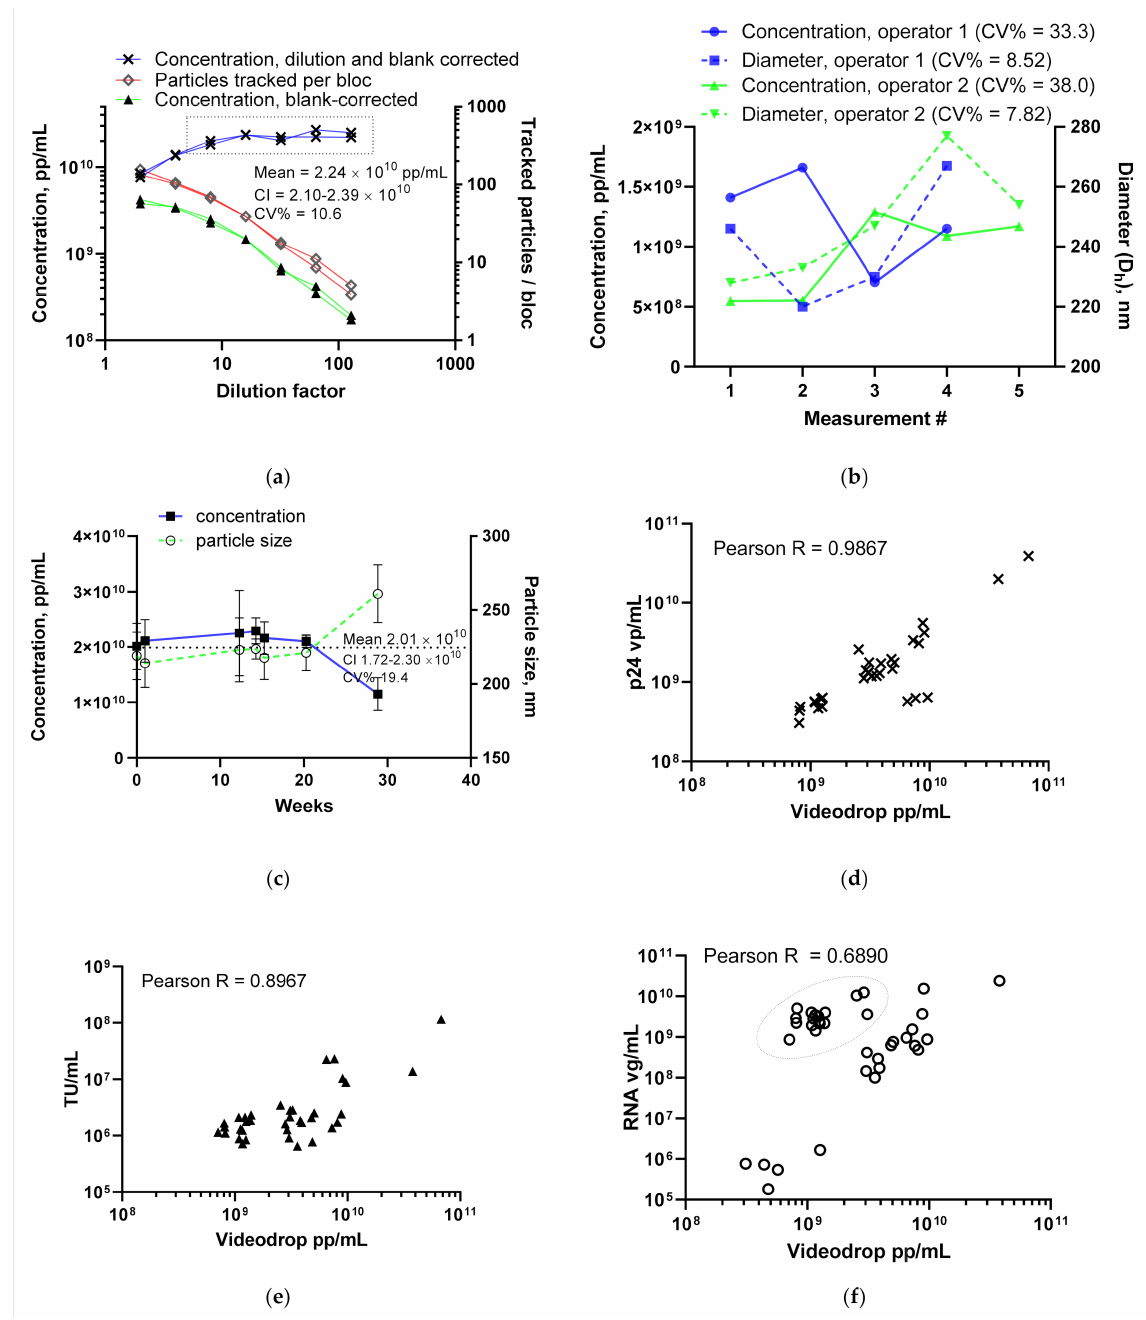
Figure 2. Videodrop LV assay results: ( a ) setting the LV assay range and minimum particle numbers. Two independent measurements of 2-fold LV dilution series (prepared fresh each time) were measured. The final blank- and dilution-corrected result as well as the blank-corrected raw reading and number of tracked particles are shown. The dotted line box shows dilutions falling within the set assay working range with their mean concentration, with the CI and CV% below. ( b ) LV repeatability results from a single 8 × dilution as analyzed by two operators during a single day. ( c ) Intermediate precision results, measured from the same sample (different aliquot tubes) over several months. The mean is displayed as a dotted line, and CI and CV% are shown under the line. ( d ) Correlation between the Videodrop measurement and vp/mL p24 ELISA result. ( e ) Correlation between the Videodrop measurement and TU/mL qPCR result. ( f ) Correlation between the Videodrop and vg/mL ddPCR result. A group containing certain types of bioreactor samples showing a lower pp/mL value than expected based on the RNA genome titer is circled using a dotted